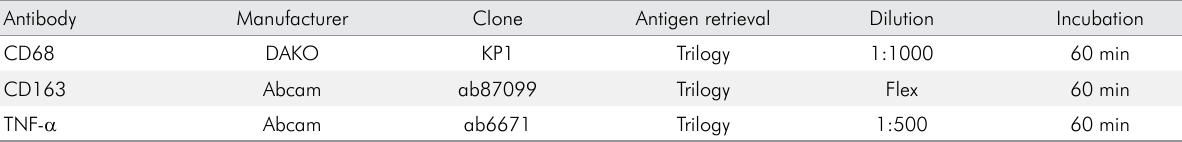
Table 1. Manufacturer, clone, antigen retrieval, dilution, and incubation period of primary antibodies.